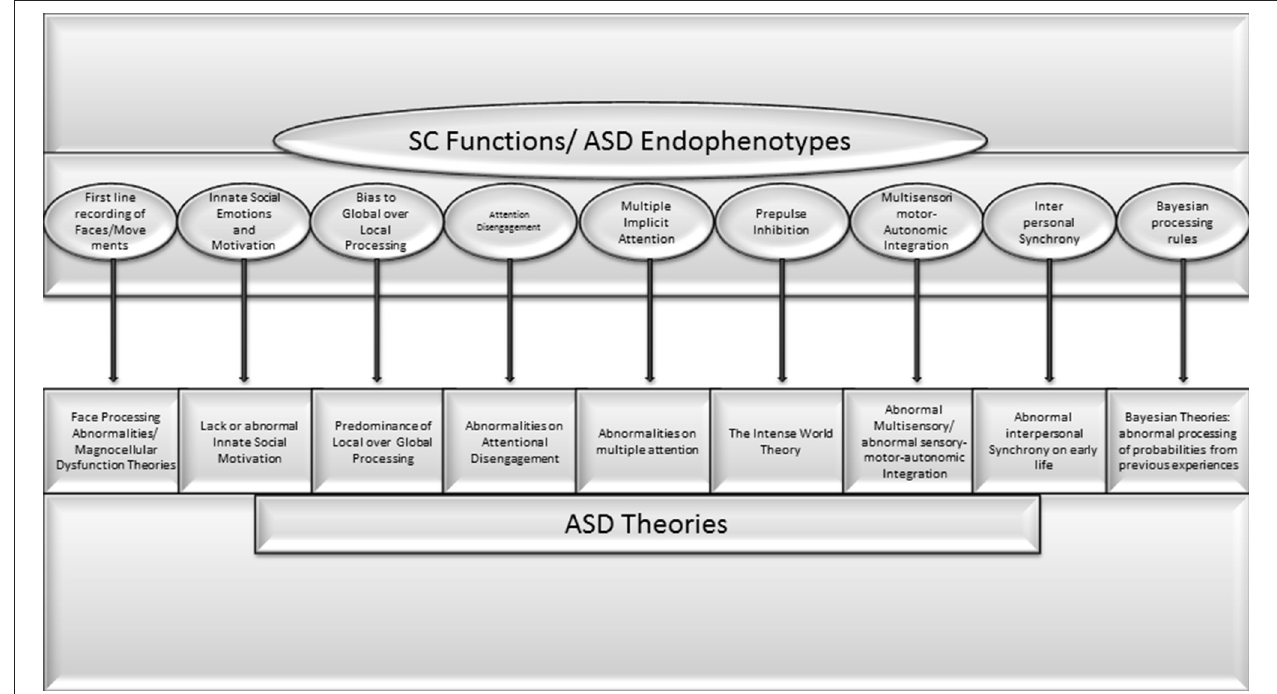
FIGURE 1 | Very high concorndance between SC functions and endophenotypes or pivotal symptoms of ASD theories previously